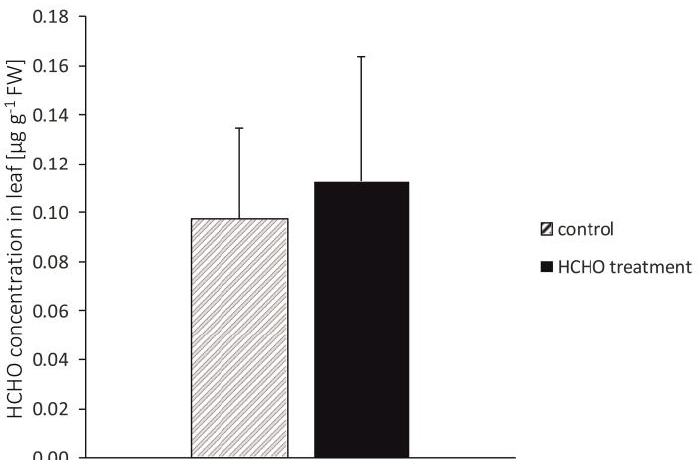
Figure 1. Effect of treatment with gaseous formaldehyde applied as 20 mg m − 3 on formaldehyde concentration in C. comosum leaf tissues after 48 h of plant exposure. The data are means ± SD.